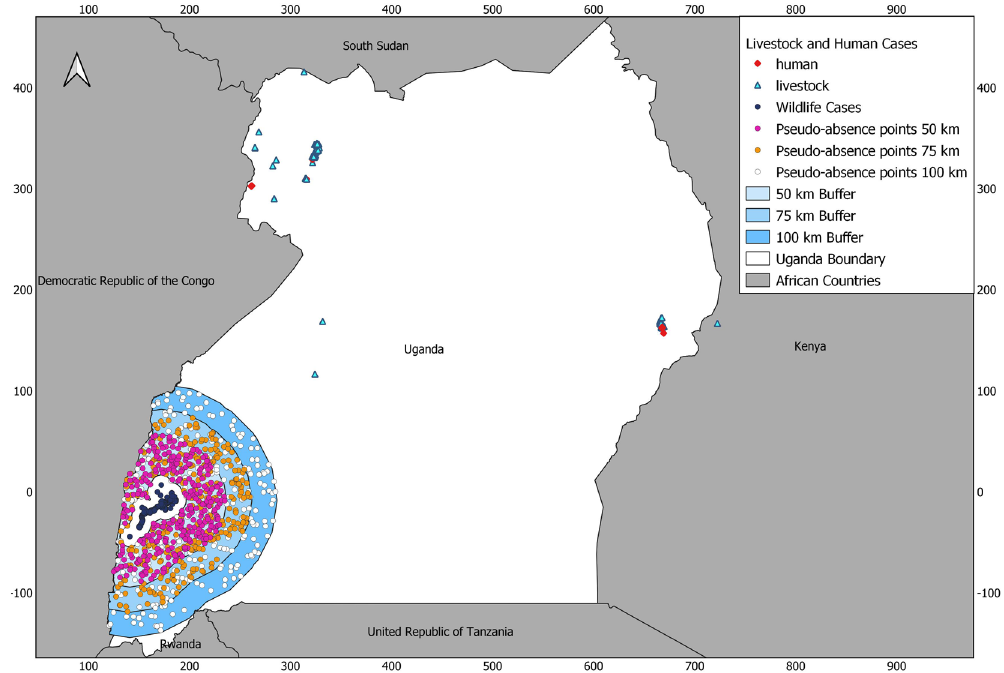
Figure 1. Distribution of anthrax presence and pseudo-absence locations across Uganda. The navy-blue circles show wildlife cases (n = 294) used for model training, the blue triangles show livestock cases (n = 171), and the red diamonds represent human cases (n = 32). The blue polygons show the locations of the 50 km, 75 km, and 100 km buffers which were constructed around the wildlife cases with a distance of 10 km between the buffers and the presence locations. The pink dots show the pseudo-absence points selected within the 50 km buffer, the orange dots show the pseudo-absence points selected within the 75 km buffer, and the white dots show the pseudo-absence points selected within the 100 km buffer. Prediction maps were developed using the Quantum Geographic Information System software (QGIS). URL: https:// qgis. osgeo. org